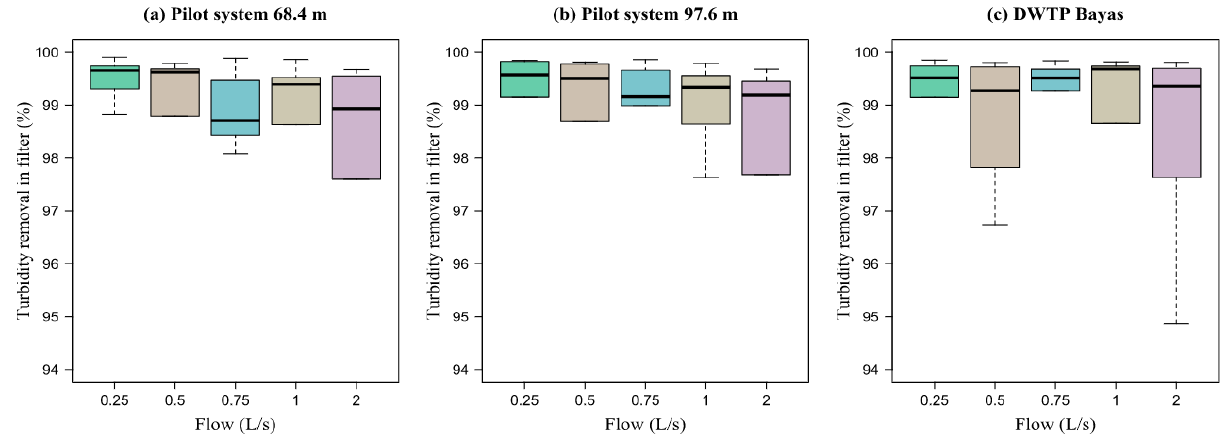
Figure 9. Turbidity removal efficiency in the filter: ( a ) With HTF of 68.4 m, ( b ) with HTF of 97.6 m, and ( c ) in the filter of the DWTP “Bayas”. The bluish-green boxes correspond to a flow of 0.25 L/s, the brown boxes correspond to a flow of 0.5 L/s, the turquoise boxes correspond to a flow of 0.75 L/s, the beige boxes correspond to a flow rate of 1.0 L/s, purple boxes correspond to a flow rate of 2.0 L/s.